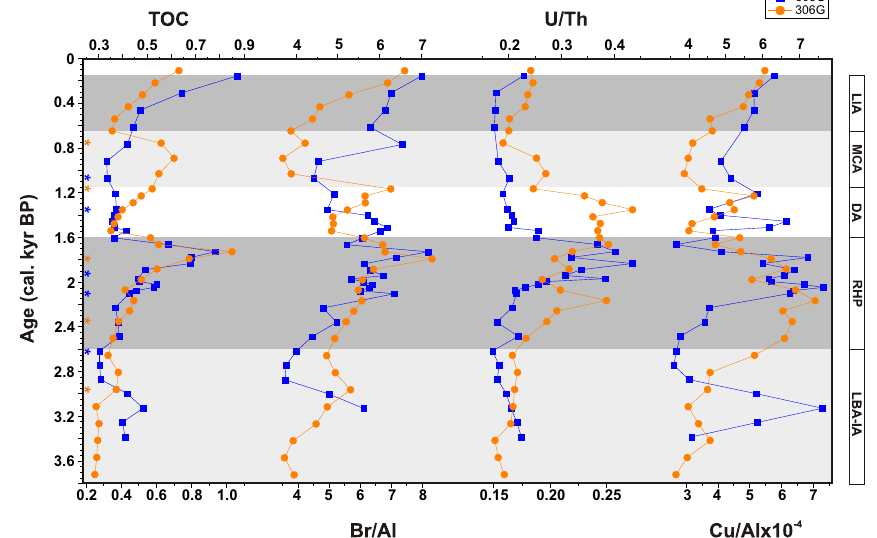
Fig. 6. Age-depth profile of paleo-productivity indicators (Cu/Al × 10 − 4 , TOC, Br/Al and U/Th) for cores 305G (blue squares) and 306G (orange circles). Light grey bars indicate dry periods (MCA: Medieval Climate Anomaly, DA: Dark Ages, LBA-IA: Late Bronze Age-Iron Age); dark grey bars indicate humid periods (LIA: Little Ice Age, RHP: Roman Humid Period). Asterisks indicate the AMS 14 C